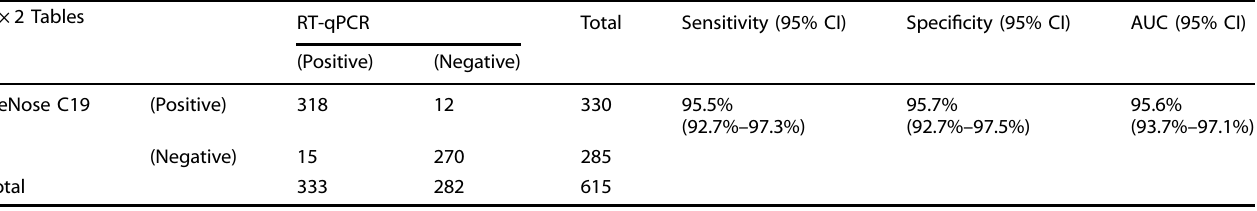
Table 2. Key parameters of GeNose C19 obtained from the optimum machine learning algorithm (DNN) of all breath samples (training and testing datasets). 2 × 2